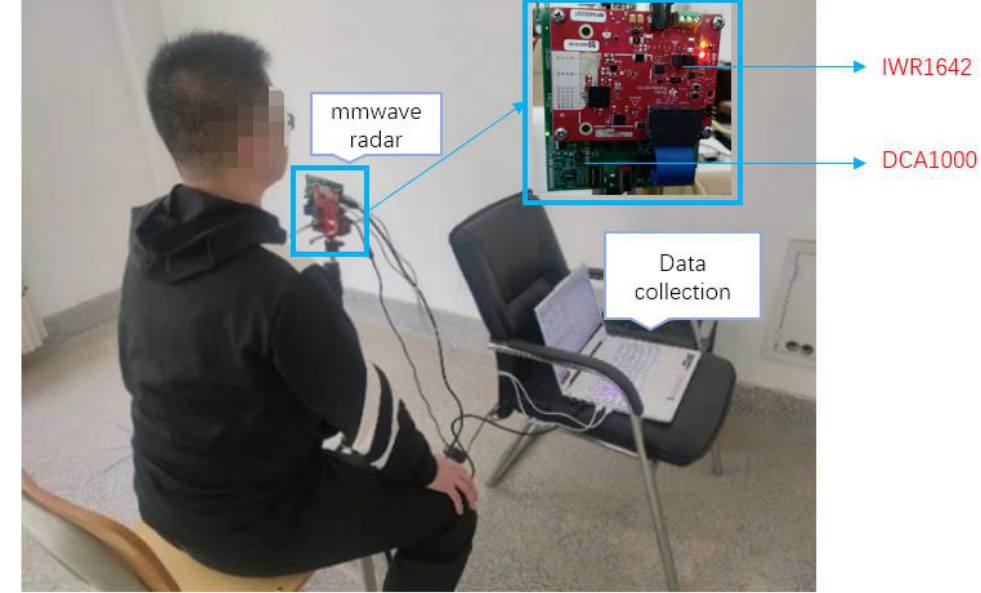
Figure 5. Experiment platform.